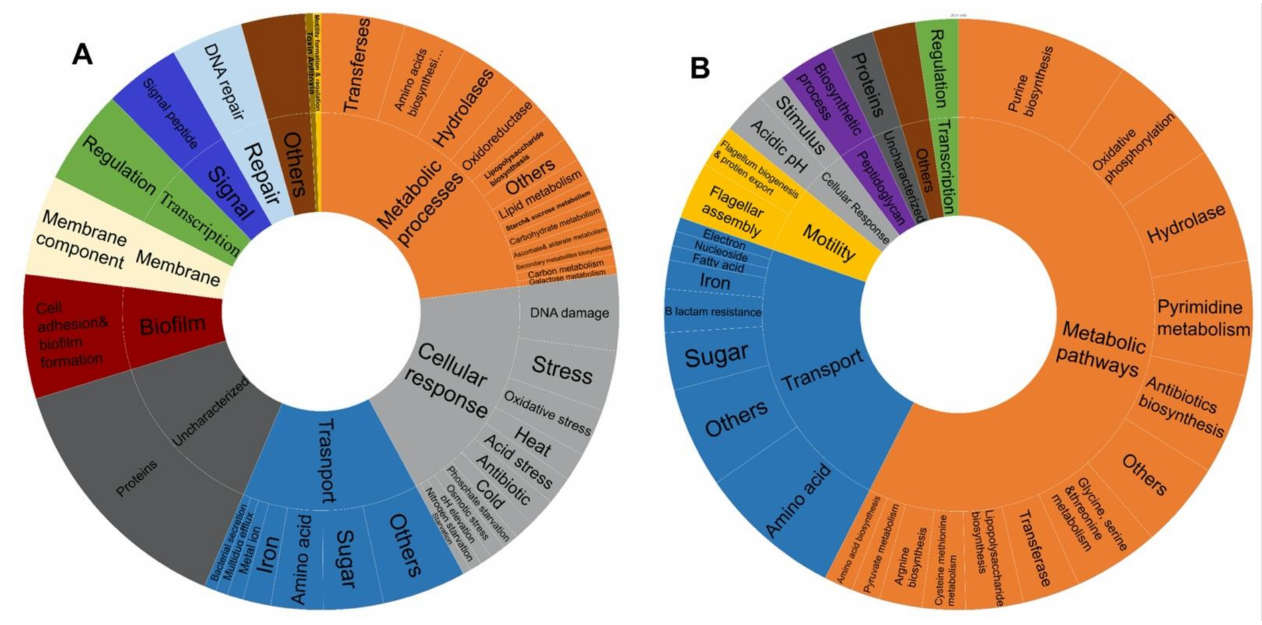
Figure 4. Pie chart displaying the distribution of functional categories among ( A ) upregulated genes, ( B ) downregulated gene shared between at least four stress conditions. The functional categories of upregulated genes common between at least three stres- sors are presented in Table 4. Table 4. Upregulated gene functions in multiple conditions (at least three